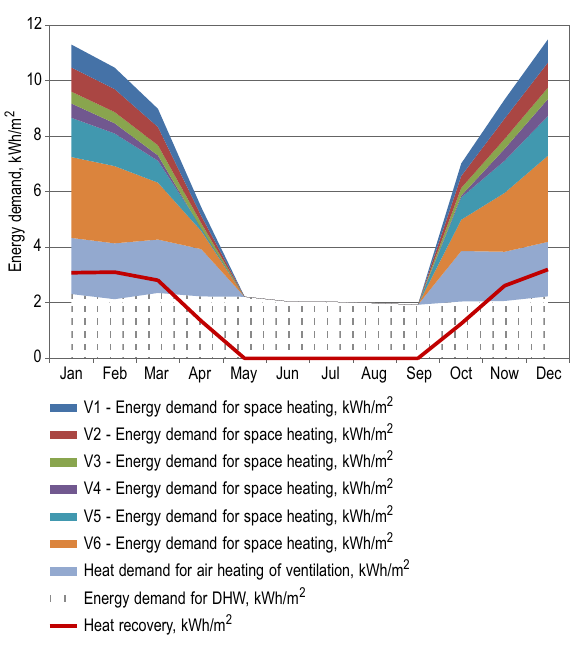
Fig. 3. The energy demand of the low energy house for space heating, ventilation and domestic hot water